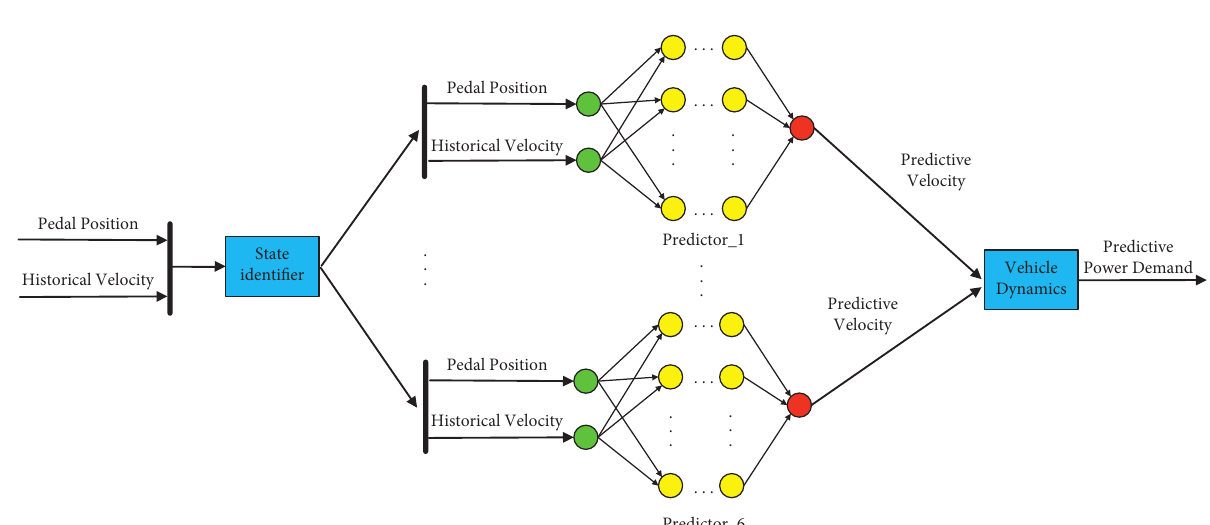
Figure 11: Proposed integrated predictor scheme for P 2